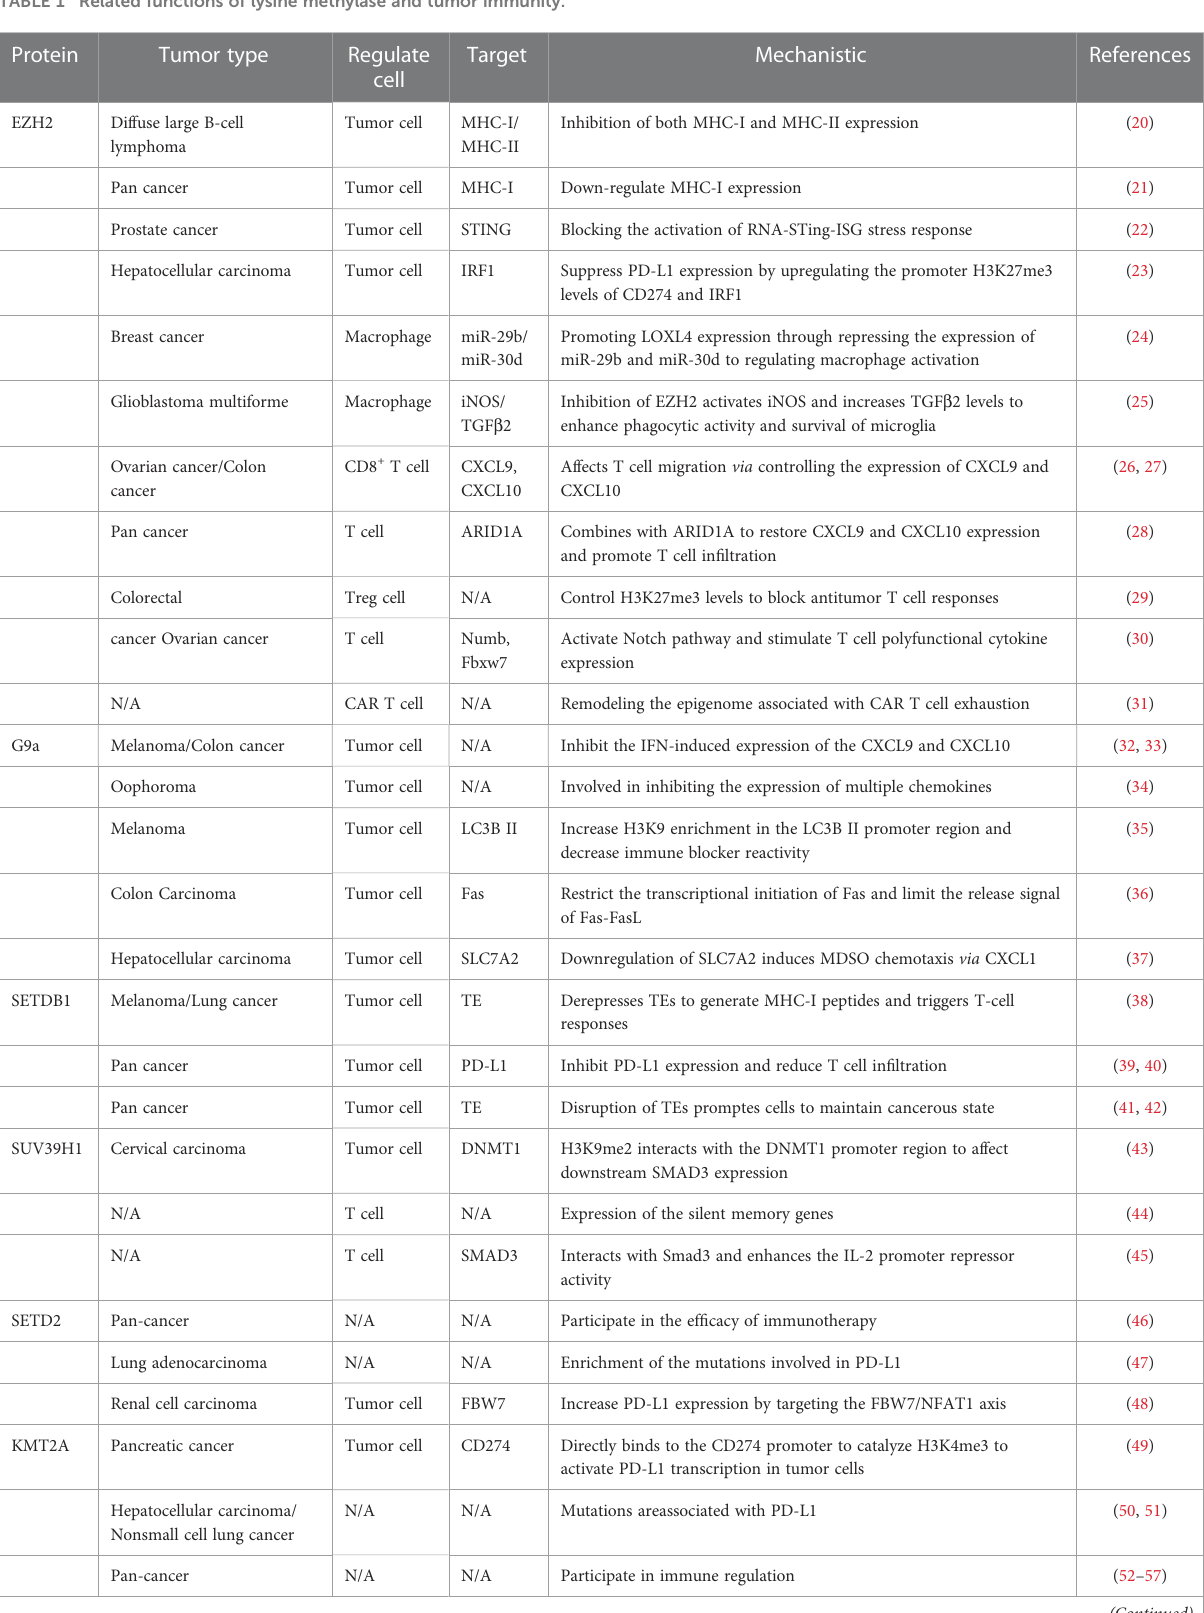
TABLE 1 Related functions of lysine methylase and tumor immunity.